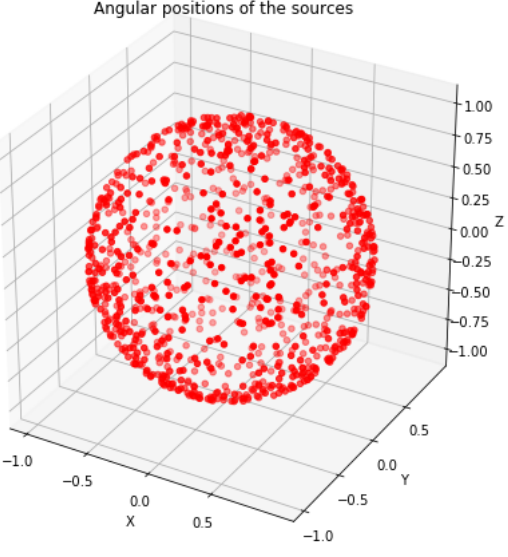
Figure 3. Angular positions of the sources.